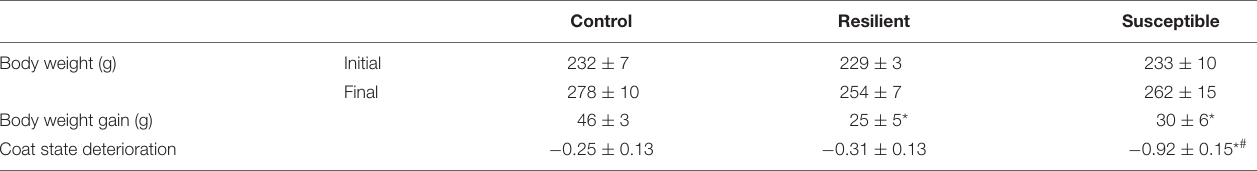
FIGURE 2 | Social parameters of the susceptible and resilient phenotypes in the SIT. The test was performed 24 h after the last SDS. Bars represent means + SEM ( n = 6–8 animals per group). (A) Interaction ratio (IR). (B) Latency to the first entry in the interaction zone. (C) Time spent in the interaction zone. (D) Time spent in the avoidance zone. * p < 0.05 relative to control group; # p < 0.05 relative to resilient group; + p < 0.05 relative to time spent in the no target phase of the same group. TABLE 1 | Body weight, body weight gain, and coat state deterioration of resilient and susceptible phenotypes to social defeat stress (SDS). Control Resilient